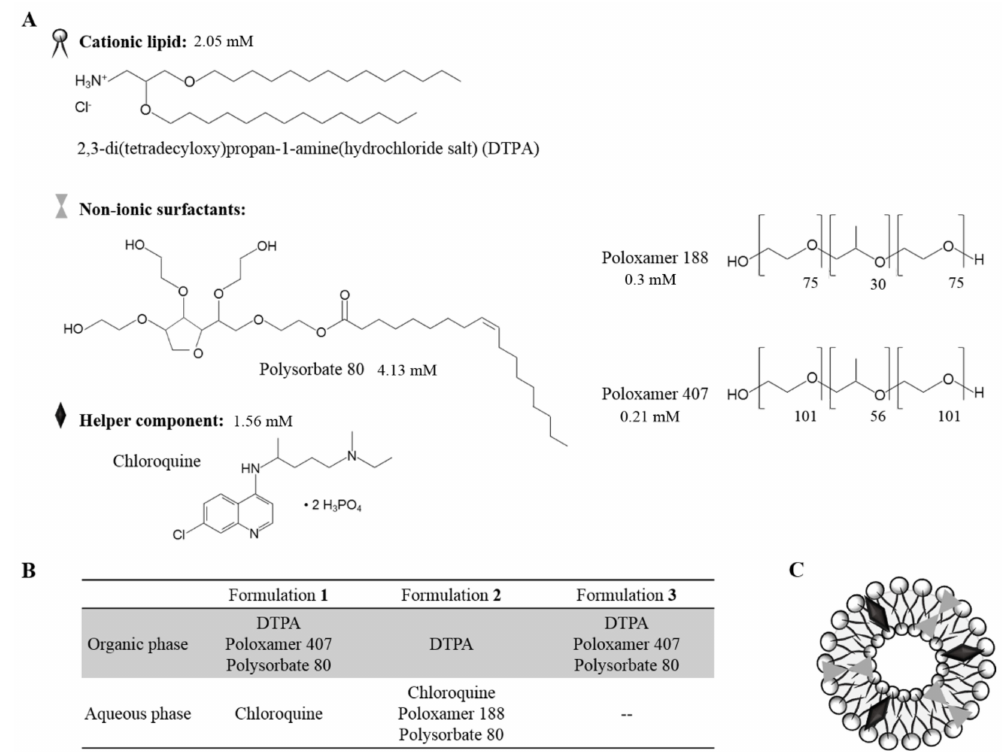
Figure 1. Structure and chemical components of niosomes. ( A ) Chemical structure and millimolar quantity of niosome components. ( B ) Description of the components in each formulation. ( C ) General scheme of a